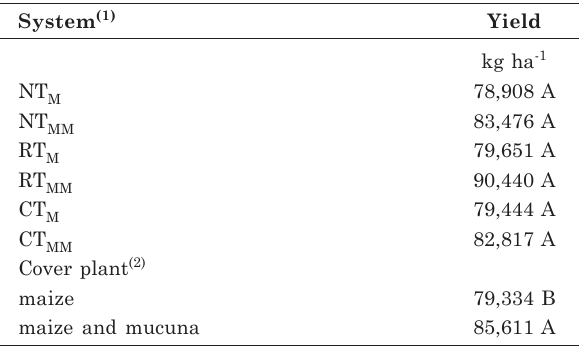
Table 6. Cabbage yield under different tillage systems and cover